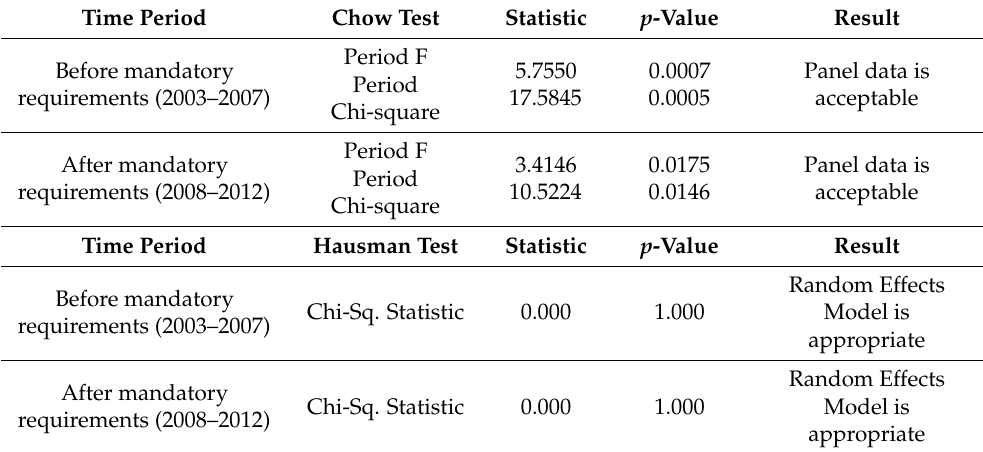
Table 10. F-limer and Hausman tests.